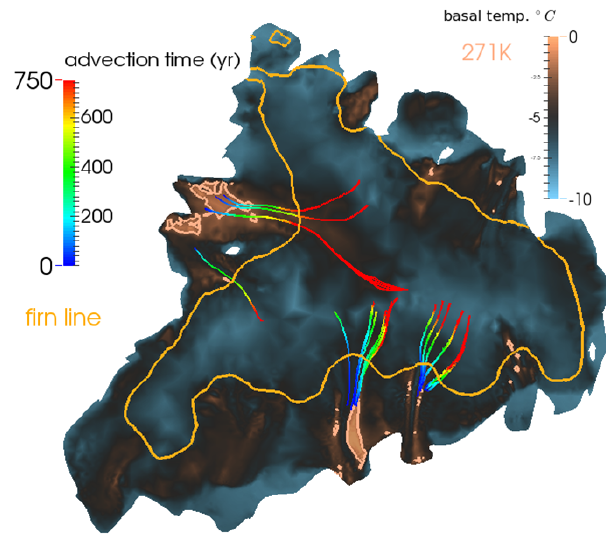
Figure 14. Typical advection timescales from the region above the firn line in the centre of the ice cap to the lower parts of the out- lets estimated from backward streamlines obtained with the back- ward Runge–Kutta method implemented in ParaView (Ahrens et al., 2005) assuming the basal friction parameter beta95T . The trajecto- ries are coloured accordingly to the advection time to its lower end (blue colour). The firn line is depicted in orange, as texture the tem- perature field 1995ss is